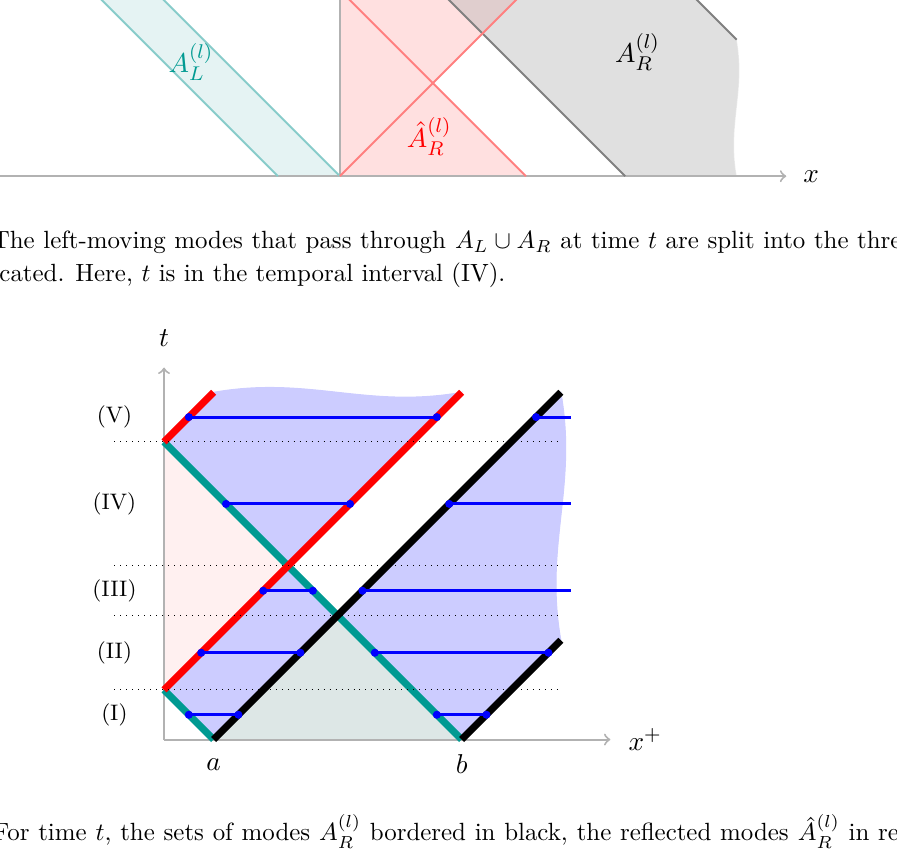
Figure 15 . For time t , the sets of modes A ( l ) and ˜ A ( l ) in green. At a given time the entropy of the modes is given by S rad for the blue areas that L correspond to A ( l ) (cid:9) ˜ A ( l ) R L